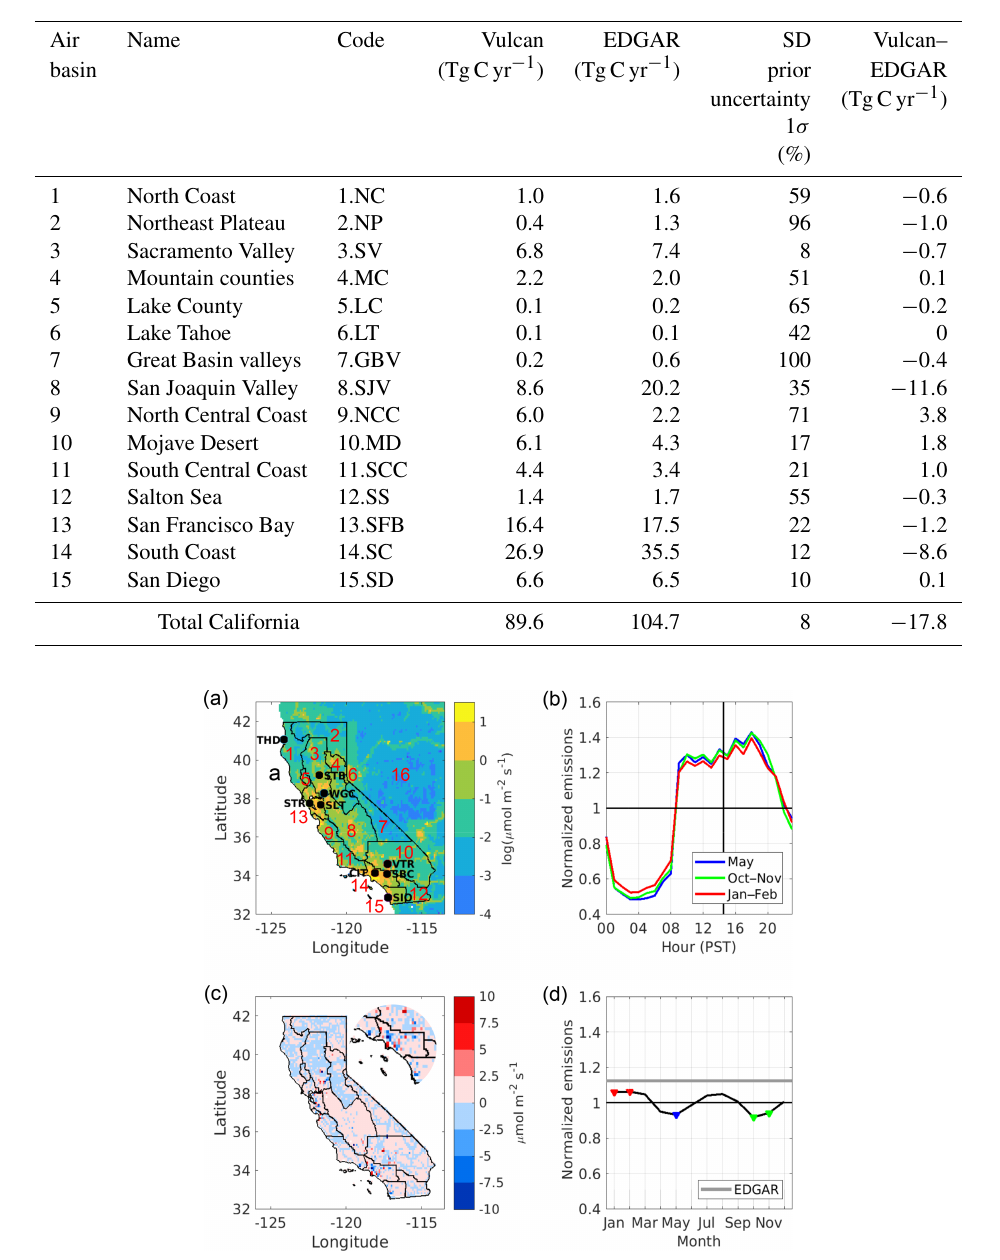
Table 1. The 15 air basins of California with respective emissions as estimated by Vulcan and EDGAR models. Also shown are the SD prior uncertainty estimate (Fischer et al., 2017) and difference in magnitude between Vulcan and EDGAR for each air basin. Air basin numbers correspond to those marked in Fig. 1.